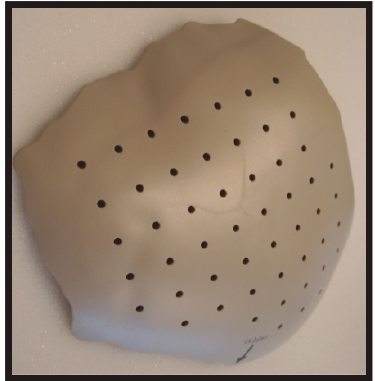
Figure 2. Patient-specific PEEK cranioplasty implant fabricated using computer-aided design and computer-aided